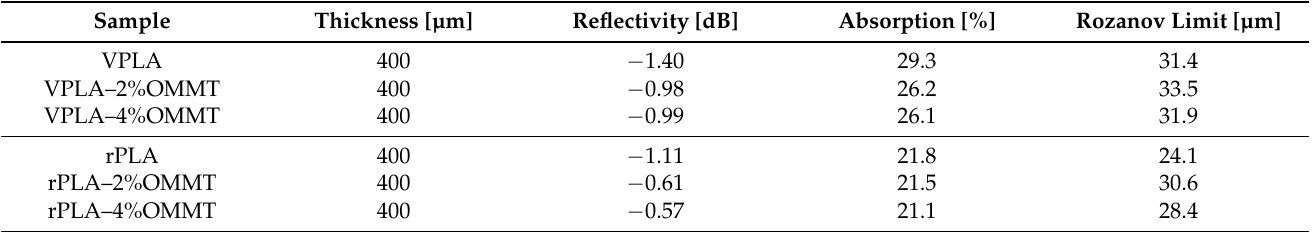
Table 1. Summary of reflectivity and absorption performances for virgin and recycled